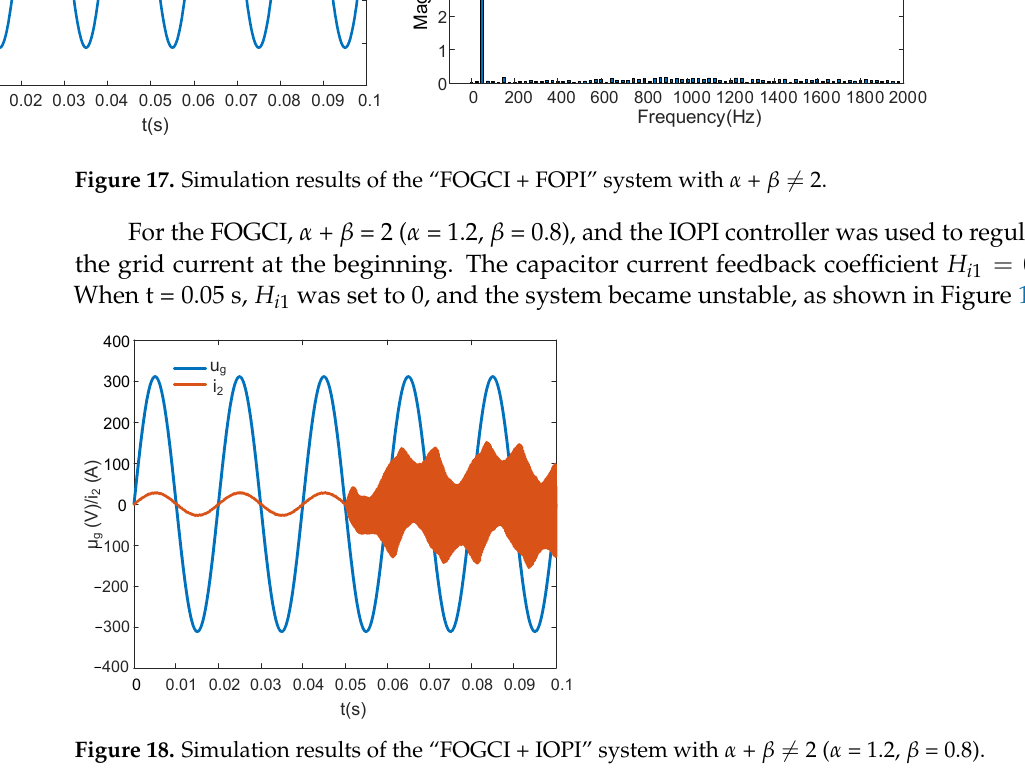
Figure 18. Simulation results of the “FOGCI + IOPI” system with α + β ≠ 2 (α = 1.2, β = 0.8).